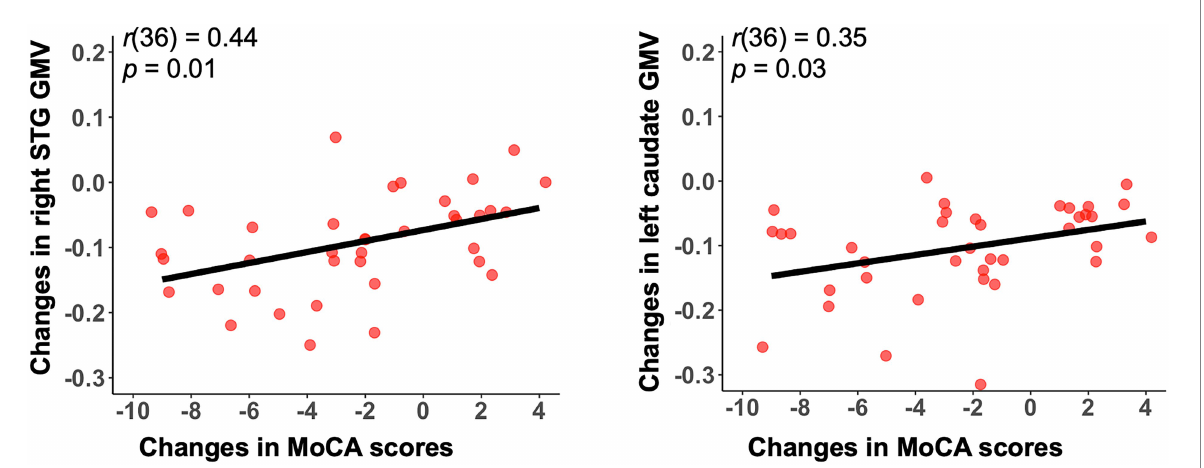
FIGURE 4 Significant correlations between change scores in the MoCA and mean GMV changes in both right STG and left caudate. Changes indicate differences between AD-T2 and AD-T1. GMV, grey matter volume; STG, superior temporal gyrus. MoCA, Montreal Cognitive Assessment.